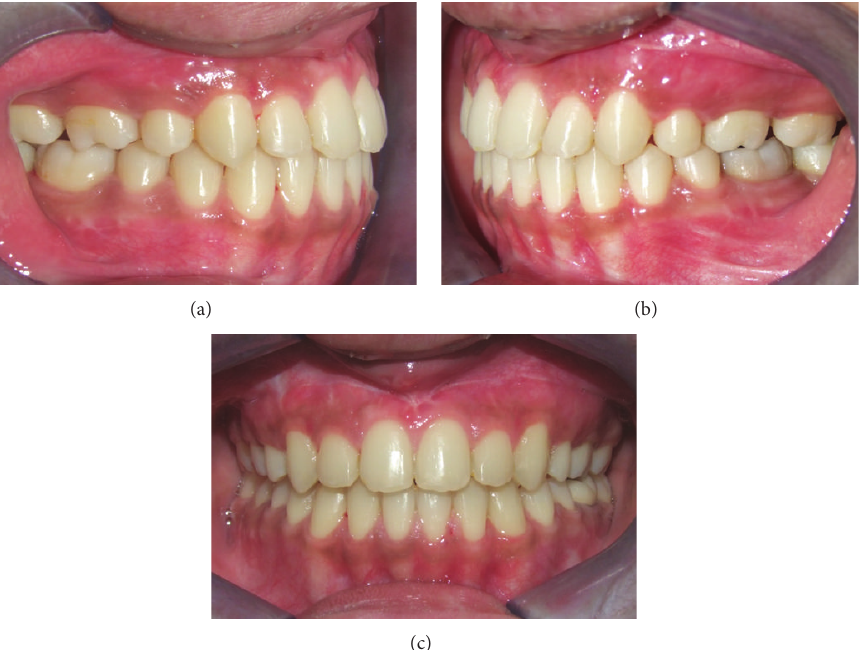
Figure 18: Posttreatment occlusion: (a) right, (b) left, and (c) front.